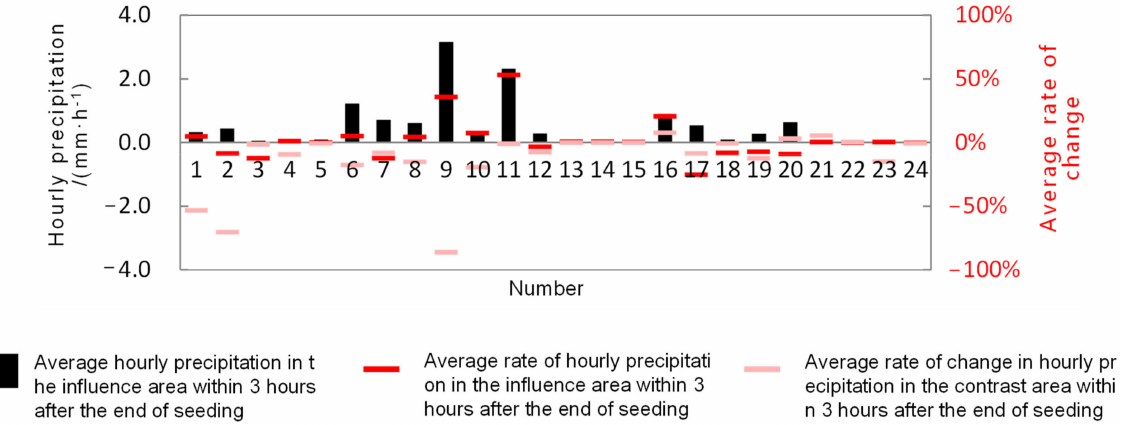
Figure 6. Mean hourly precipitation of influence area, mean change rate of hourly precipitation of affected area, and contrast area for 3 h after 24 aircraft precipitation enhancement